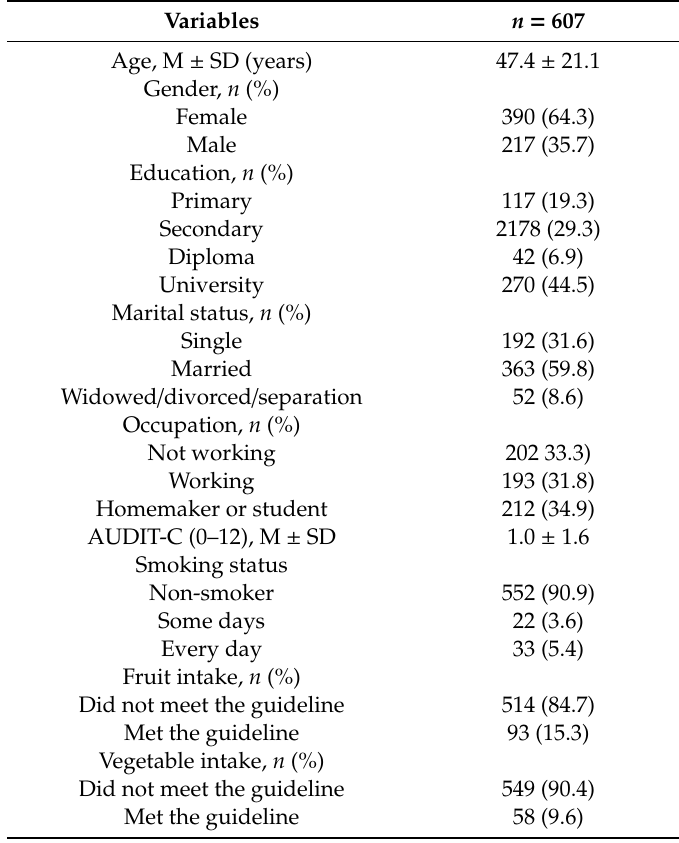
Table 1. Descriptive